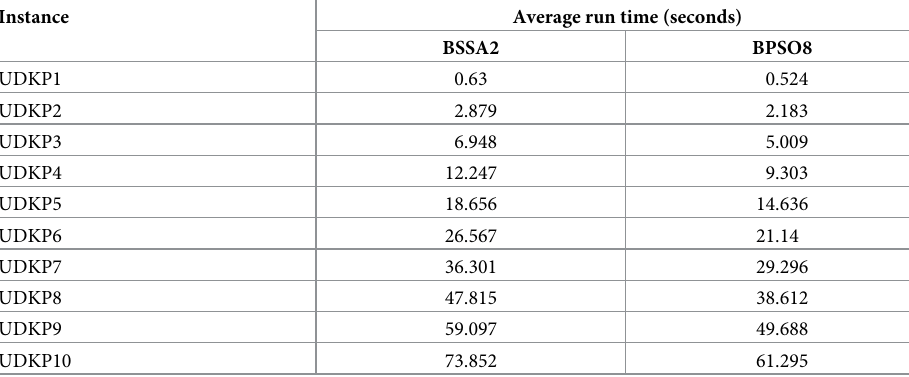
Table 10. Average run time of BSSA2 and